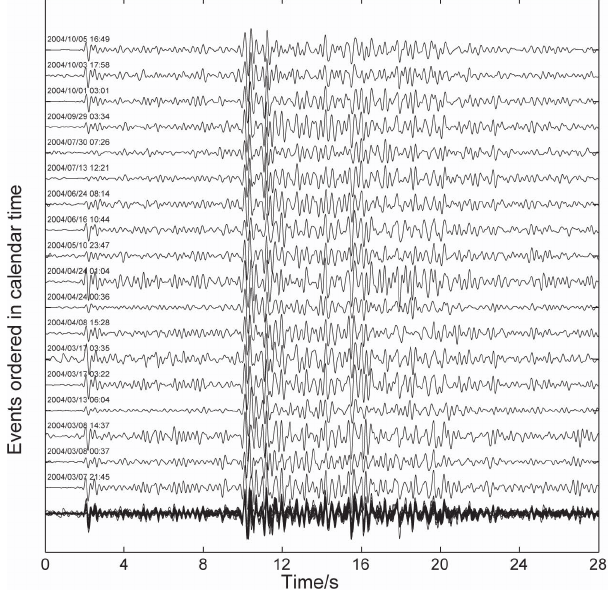
Fig. A1. Filtered seismograms of the Xiuyan “multiplet” recorded at the Yingkou (YKo) station. The figure shows part of the seismograms recorded by the Yingkou station (YKo, BB seismograph), in which “part of” means that for the 57-plet, only the seismograms of the first 31 events before and immediately after the Xiuyan earthquake are shown. In the figure, each trace has been normalized and pre-processed by a 0.5 ∼ 5Hz band pass filter. Bottom trace is the stacking of all the above traces. The clearness of the stacked trace indicates the similarity of the waveforms. Note that the “repeaters” are identified by the criteria that filtered waveforms of at least 3 stations (not necessarily including the YKo station) have the cross-correlation coefficients no less than 0.8. For some of the events, there are no waveform recordings at the YKo station.